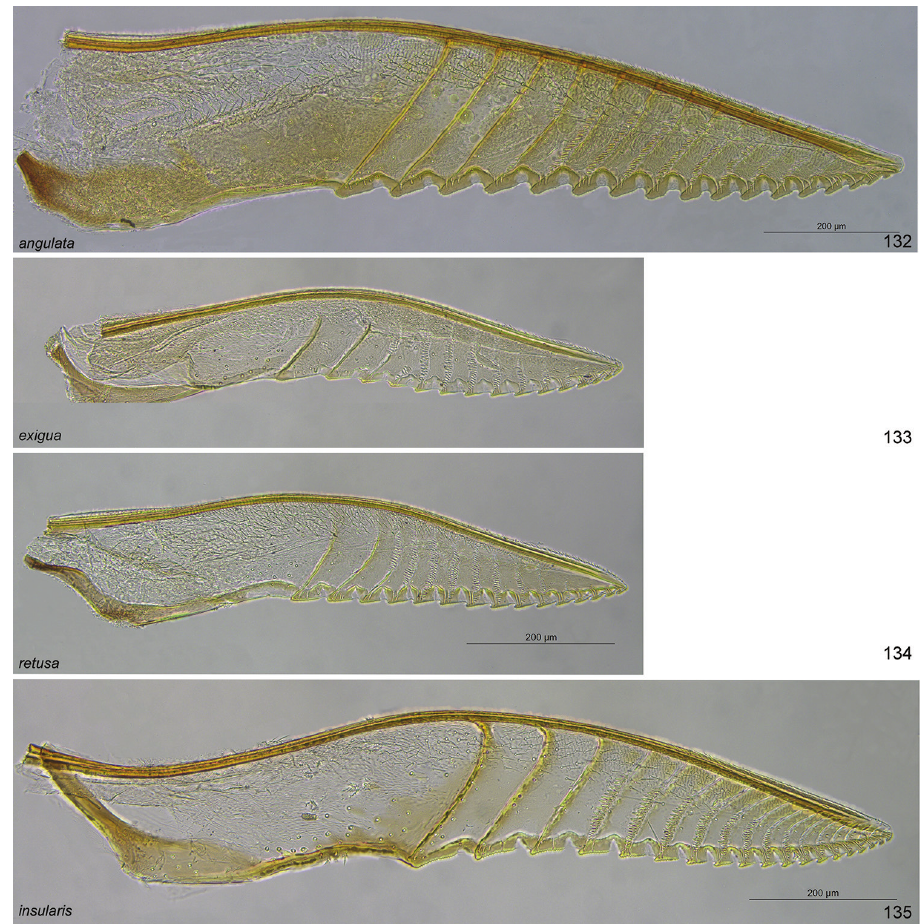
Figures 132–135. Lancets of Pristiphora . 132 angulata DEI-GISHym31671 133 exigua DEI- GISHym31527 134 retusa DEI-GISHym20965 135 insularis